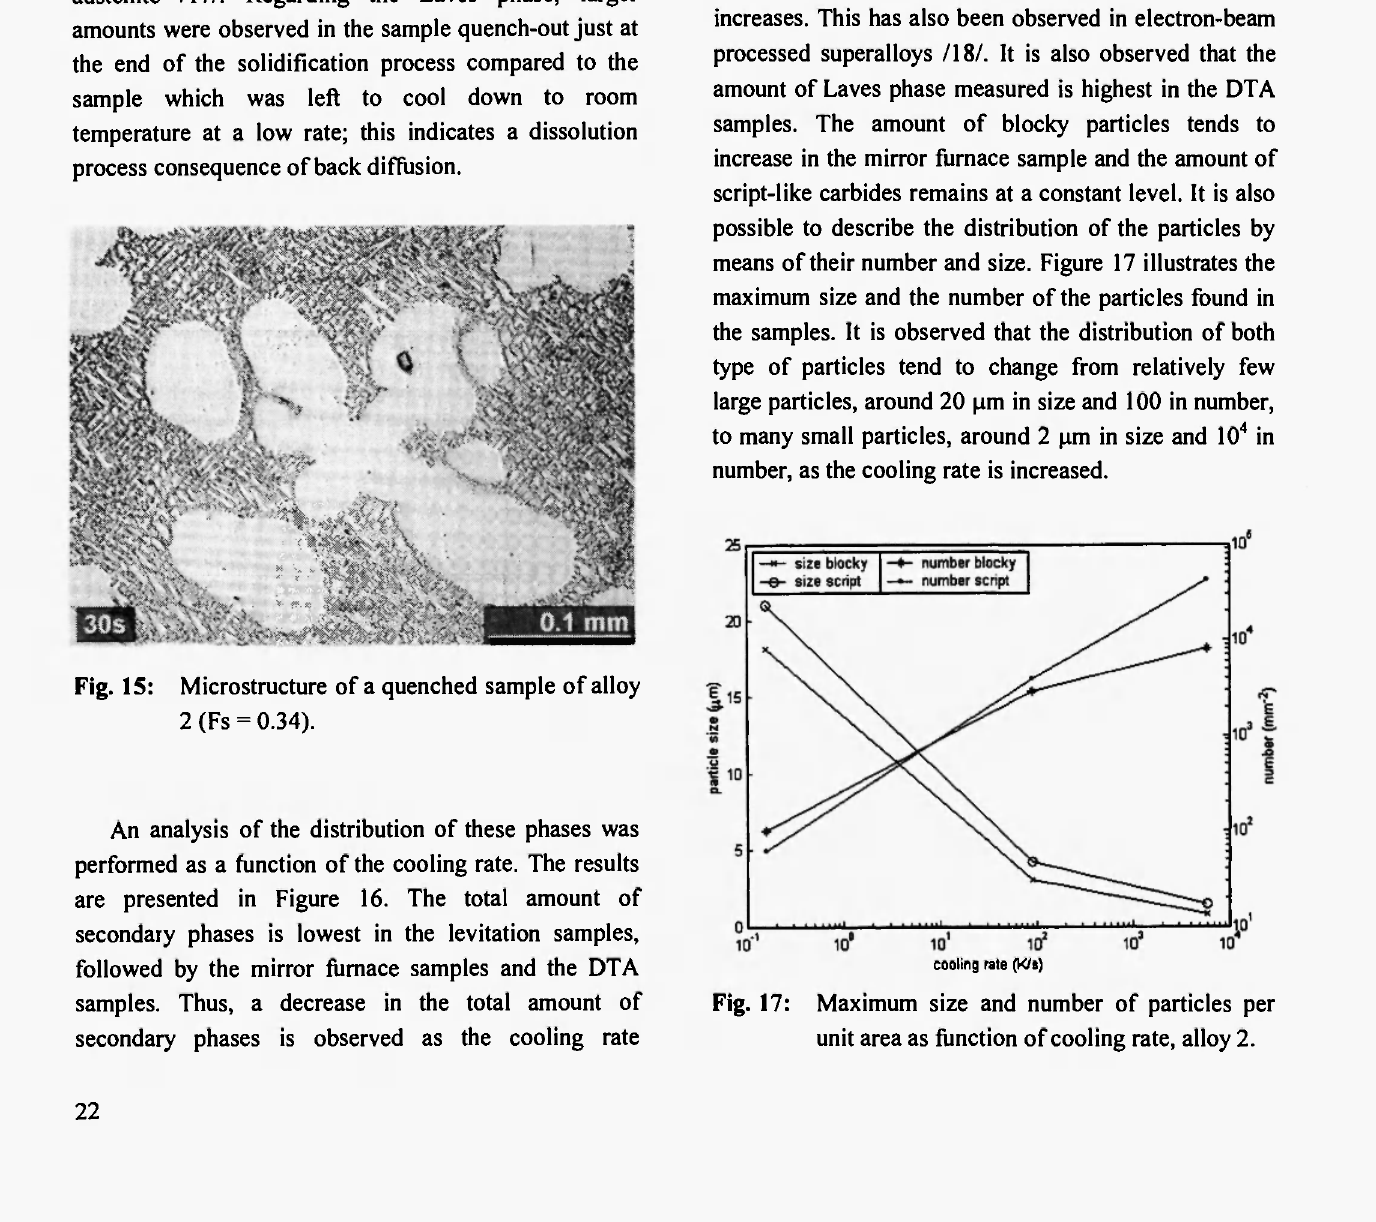
Fig. 16: Phase fraction measured in alloy 2 samples.